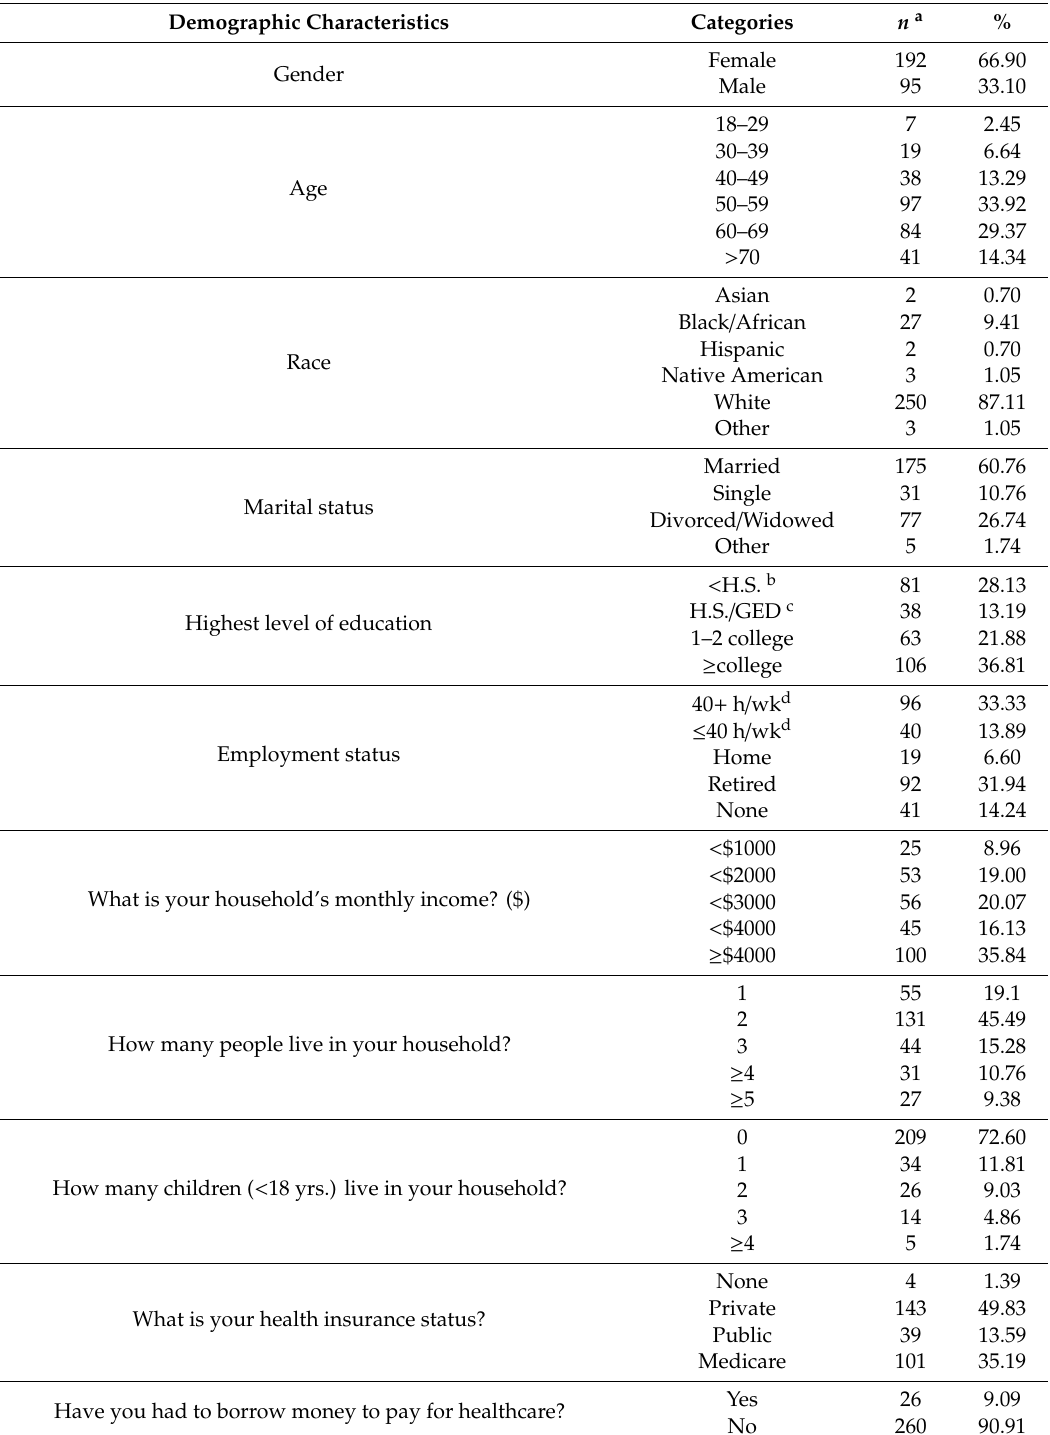
Table 1. Demographic Factors of Surveyed Patients ( N =